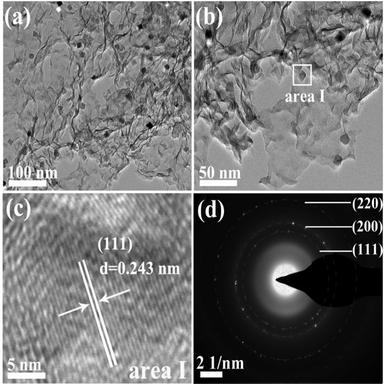
(a) The TEM image and (b) the enlarged TEM image of the TiN/NG. (c) The HRTEM image of the area I in (b). (d) SAED pattern.